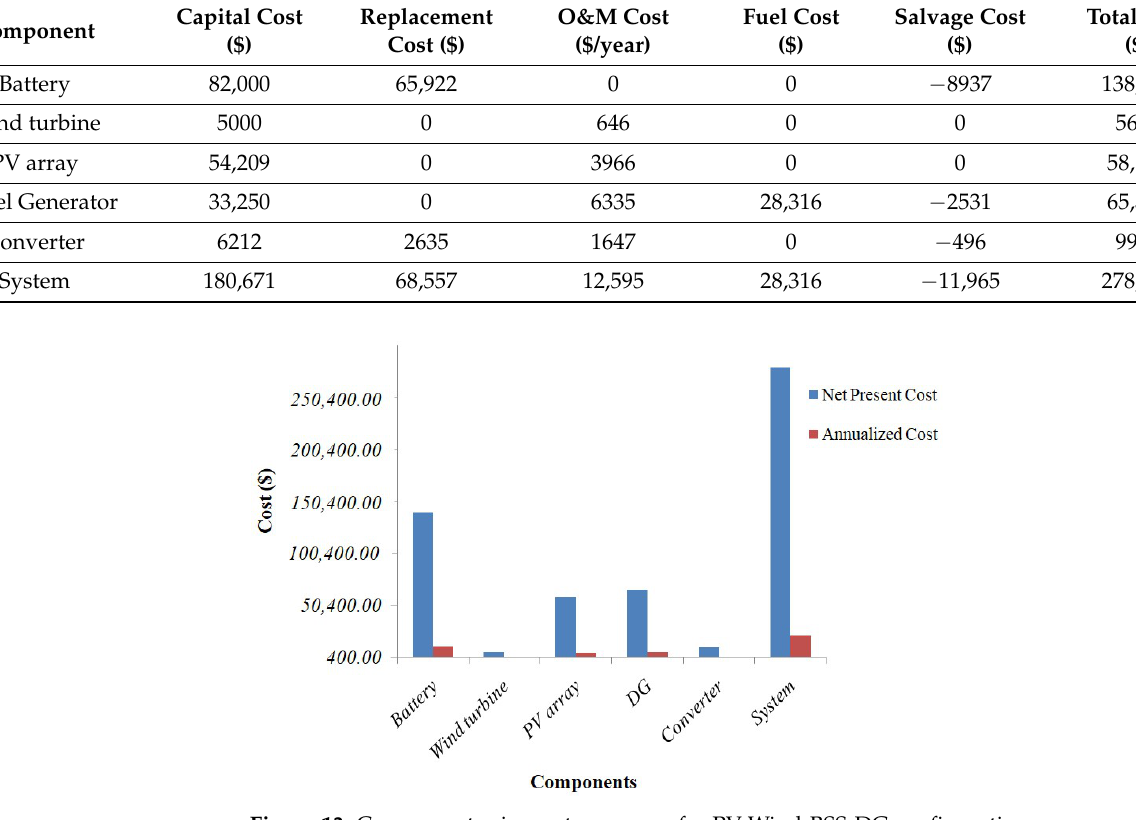
Figure 13. Component-wise cost summary for PV-Wind-BSS-DG configuration.